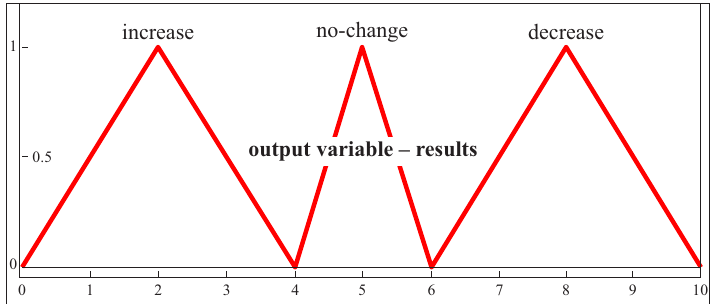
Figure 10. The membership functions for the output parameter in the case of both free-form surfaces and the second part of the expert system.